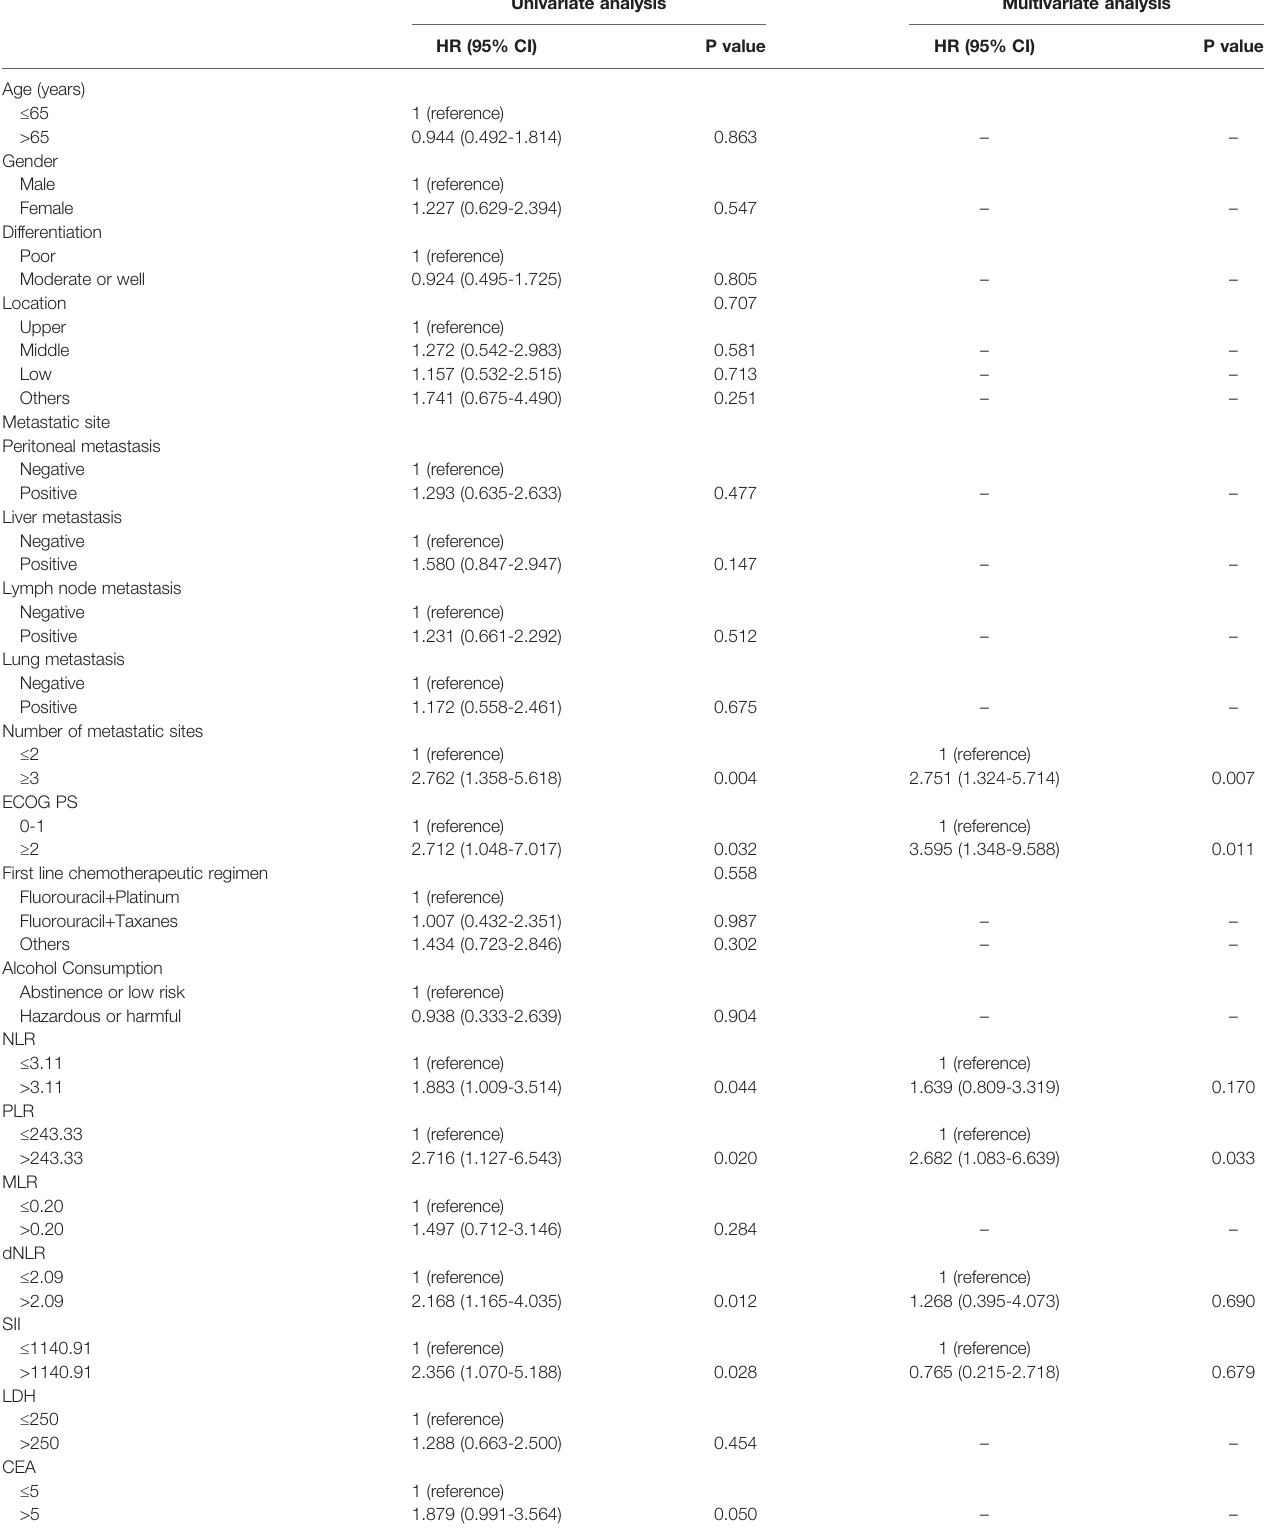
TABLE 4 | Univariate and multivariate analysis of factors according to PFS in AGC patients treated with anti-PD-1 drugs in the second-line or posterior